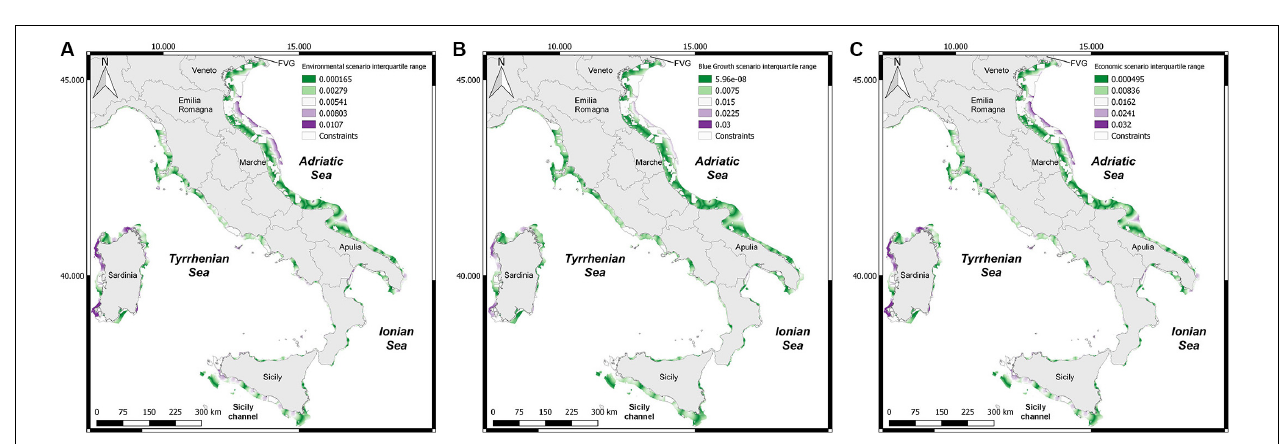
FIGURE 3 | Spatial multi-criteria evaluation median results for the 3 scenarios considering the current sea uses and protected areas. (A) Environmental. (B) Blue Growth. (C) Economic. Scenarios were defined by initially assigning the same weight to EC and EN (Blue growth, EC 0.5/EN 0.5), and therefore decreasing by 50% each macro-criterion (Economic, EC 0.75/EN 0.25; Environmental, EC 0.25/EN 0.75).